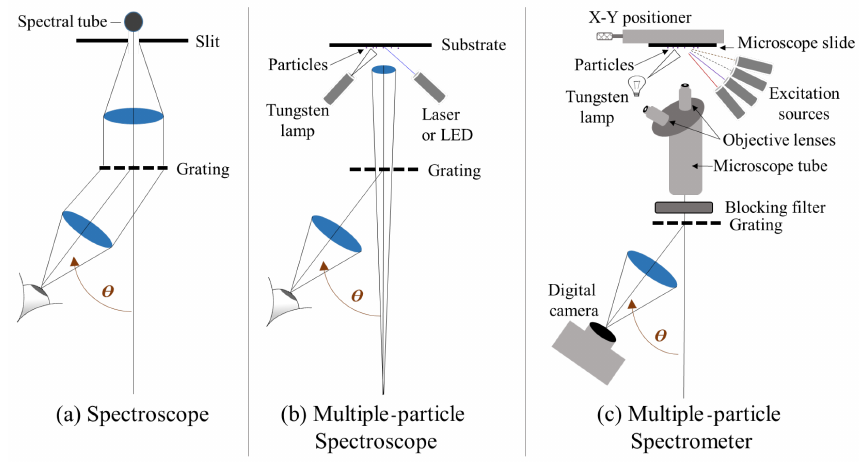
Figure 1. Three-stage progression of spectrometer. (a) Spectroscope, as often utilized in student laboratories. (b) Multiple-particle spectro- scope. (c) Multiple-particle spectrometer (introduced here). For standard benchtop setup approximate distances are as follows: objective lens to grating – 20.5cm; grating to camera –